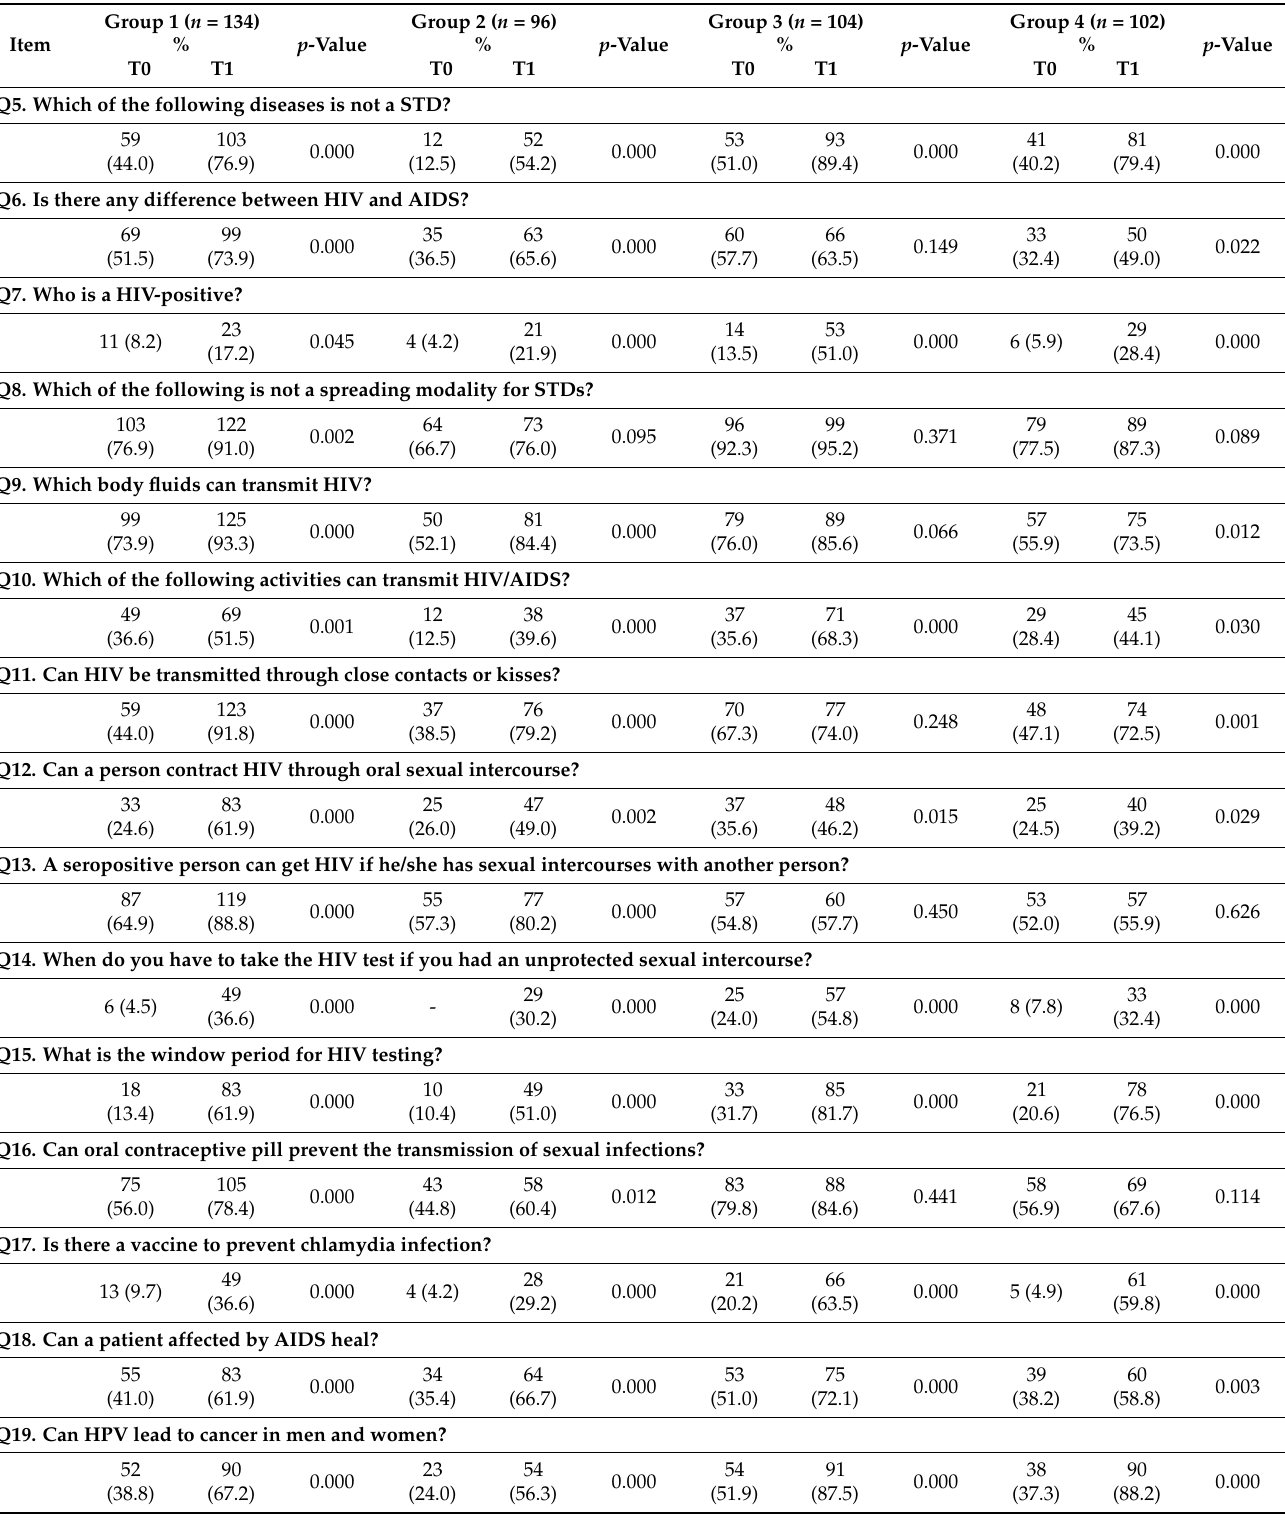
Table 4. Knowledge about HIV and STDs before (T0) and after (T1) the educational